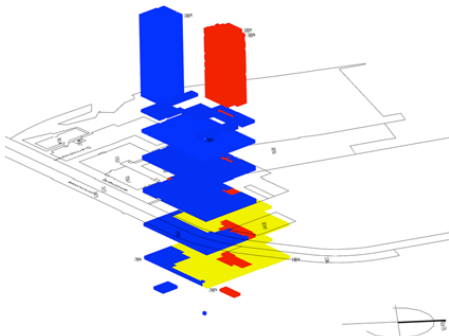
Figure 7. Exploded view of the legal volumes of the Amsterdam case in 3D PDF. Red = residential building; Blue = congress centre; Yellow = underground parking garage.